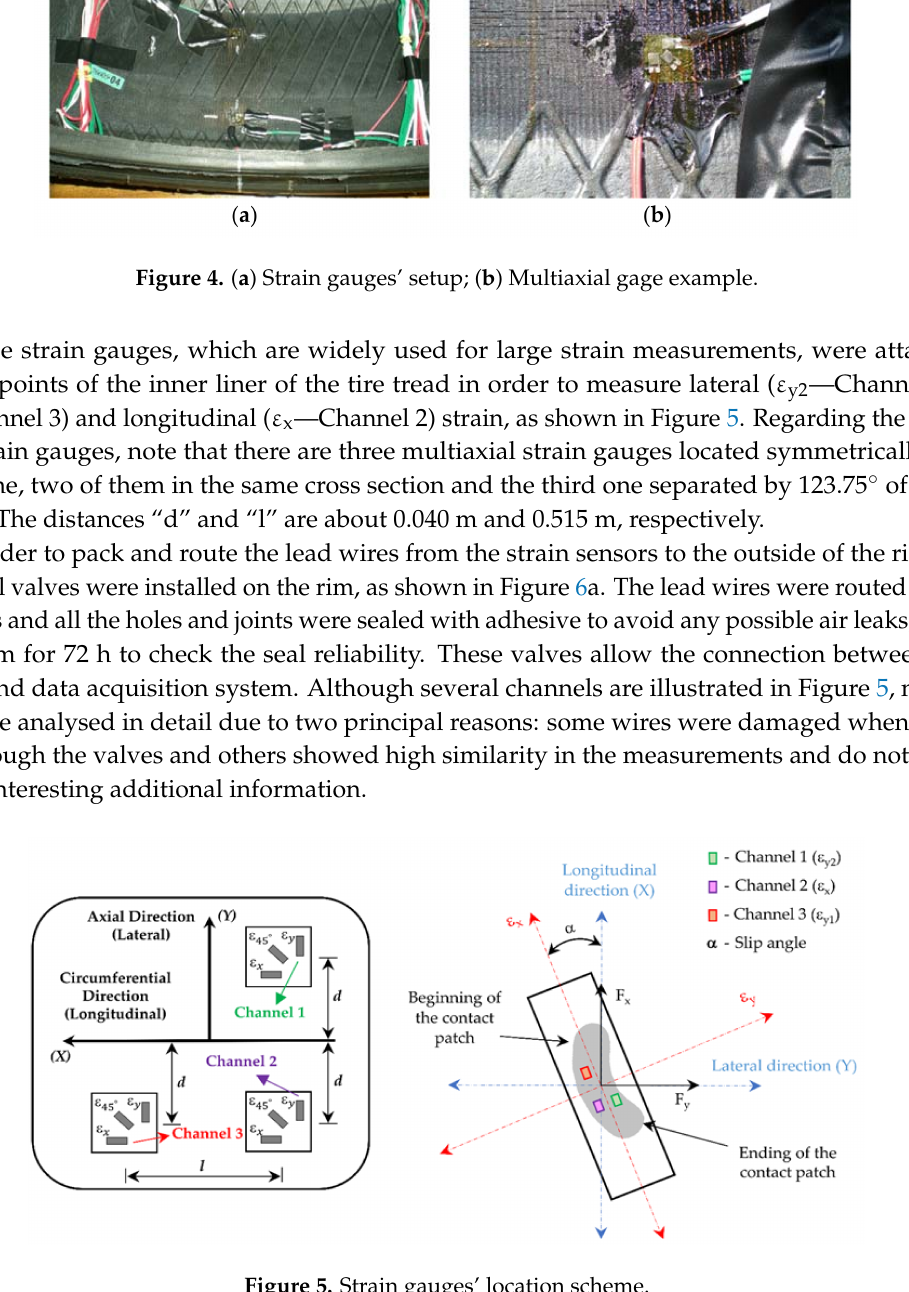
Figure 5. Strain gauges’ location